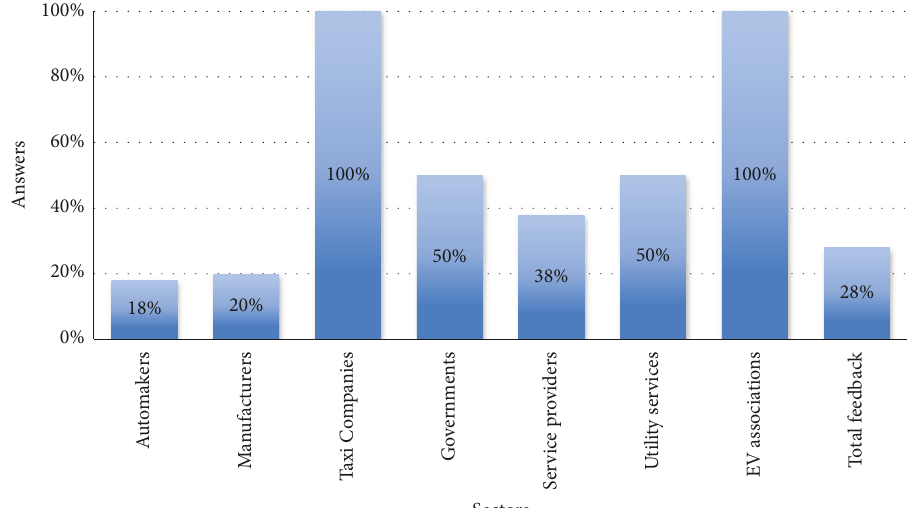
Figure 2: Replies received from the